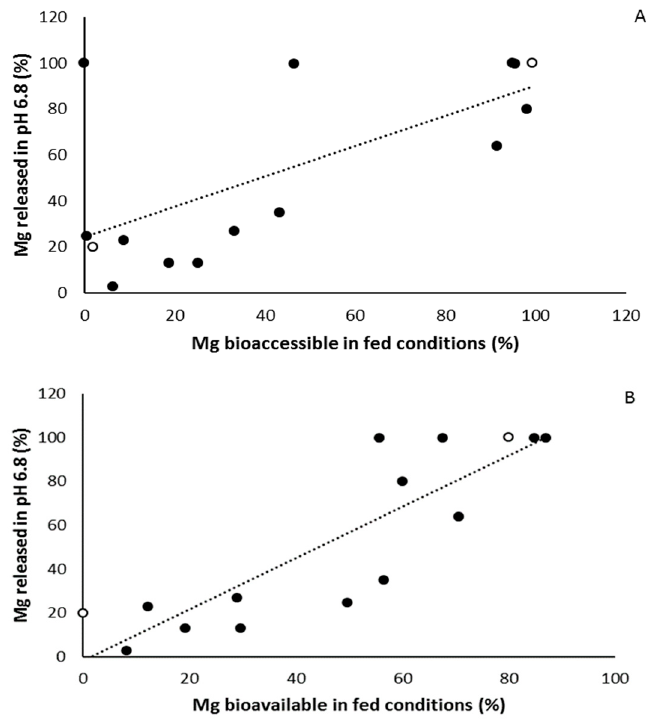
Figure 3. ( A ) Significant correlation between percentage Mg released in pH 6.8 (dissolution testing) and Mg bioaccessible in fed conditions (Simulator of the Human Intestinal Microbial Ecosystem (SHIME) testing). ( B ) Significant correlation between percentage Mg released in pH 6.8